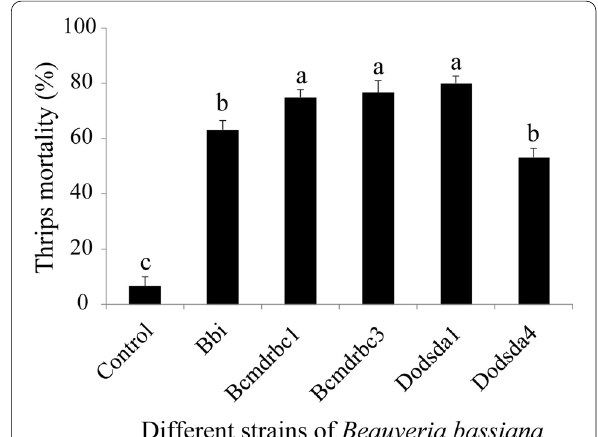
Fig. 1 Mortality rates of Megalurothrips usitatus different Beauveria bassiana strains 4 days after exposure to fungal spores. The bars marked with the same letter were not significantly different according to Turkey at p > 0.05. Bars with different letters are significantly